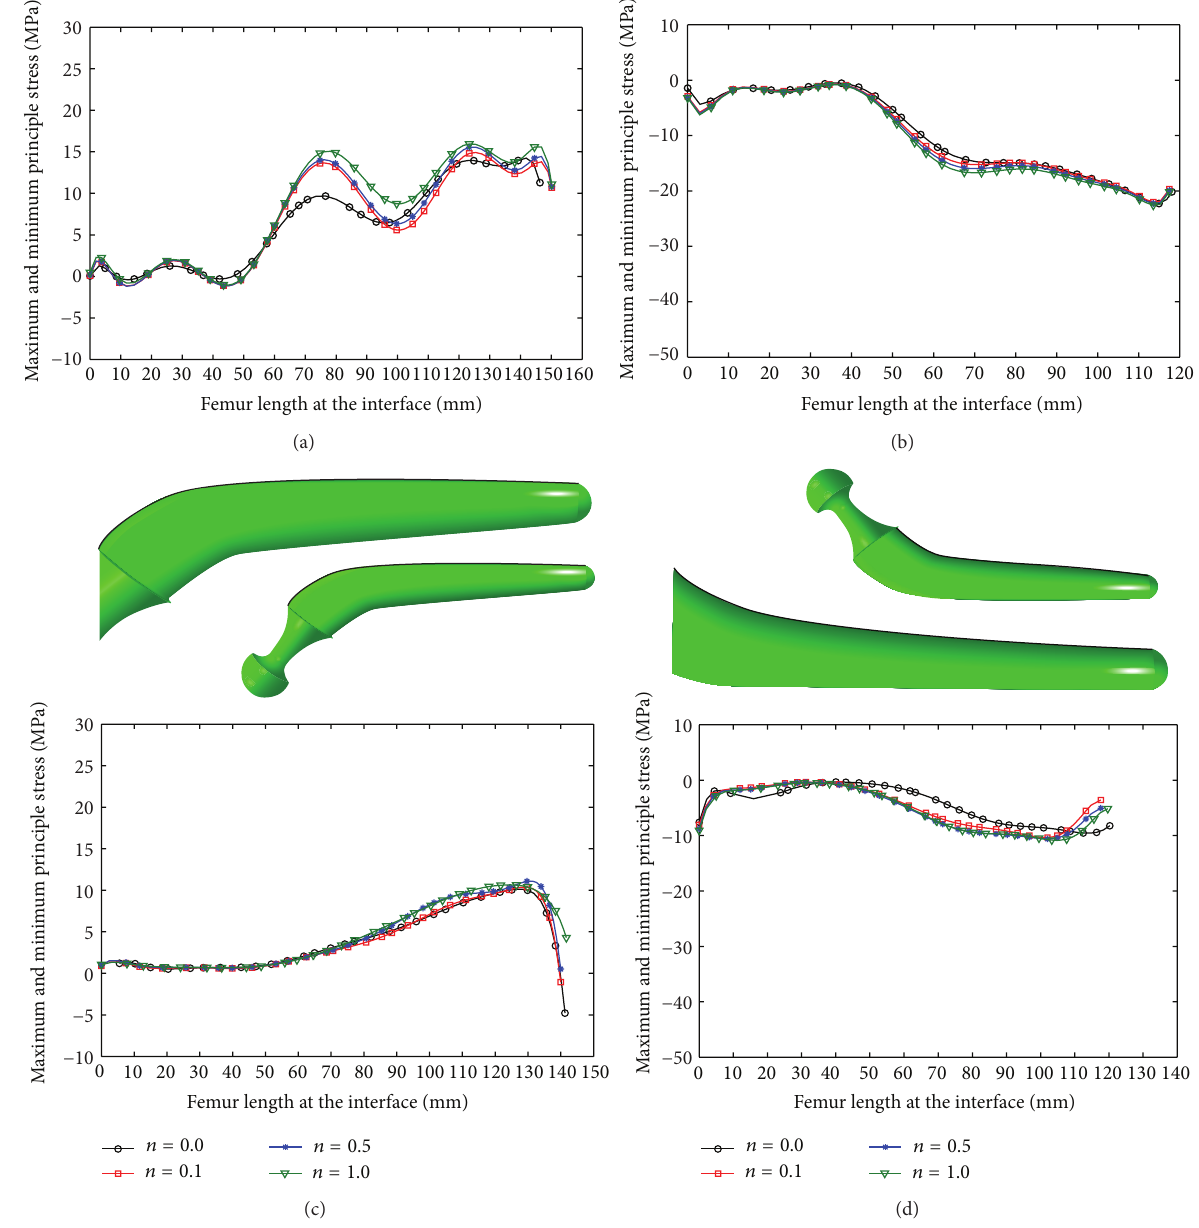
Figure 9: Stress variation on the internal surface of the femur under normal walking: (a) maximum principal stress, cemented prosthesis, (b) minimum principal stress, cemented prosthesis, (c) maximum principal stress, noncemented prosthesis, and (d) minimum principal stress, noncemented